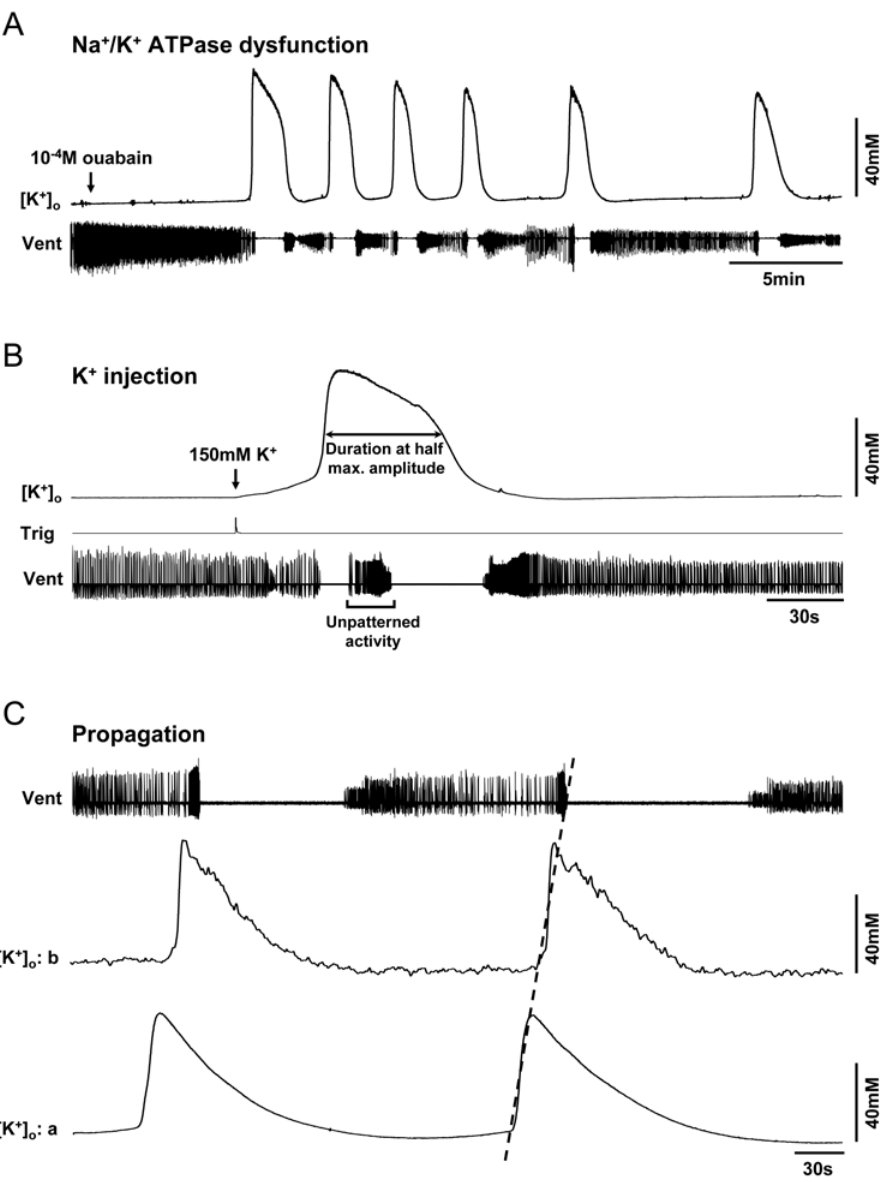
Figure 2. Characteristics of [K + ] o surges. Simultaneous recordings of the ventilatory motor pattern (Vent), a monitor of pressure-injection of a bolus of K + within the MTG (Trig in B ) and the extracellular potassium concentration ([K + ] o ). A. Continuous bath application of 10 2 4 M ouabain elicited multiple surges in [K + ] o (N=13). In the experiment shown here it took 434 seconds for 10 2 4 M ouabain to penetrate the MTG and induce failure of motor pattern generation. B. A 35 nl pressure-injection of locust saline containing a 15-fold higher [K + ] (150 mM compared to 10 mM) into the MTG neuropile was sufficient to bring [K + ] o to threshold and induce an abrupt surge (N=18). C. Two K + -sensitive microelectrodes were inserted in different regions of the MTG ( a and b ) to illustrate propagation (dotted line). In this experiment the propagation speed was 1.9